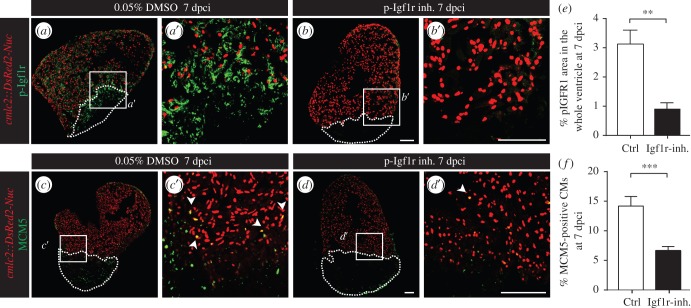
Inhibition of IGF signalling impairs CM proliferation. (a–d) Sections of cmlc2::DsRed2-Nuc (red) hearts at 7 dpci reveal that the treatment with 5 µM NVP-ADW742 (inhibitor of Igf1r) significantly reduces p-Igf1r levels (a,b, green) and MCM5-positive CMs (c,d, green). (e–f) Quantification of p-Igf1r (e, N ≥ 4) and the number of proliferating CMs (f, N ≥ 10) in the whole ventricles at 7 dpci. **p < 0.01, ***p < 0.001. Dashed lines encircle the cryoinjured areas. Scale bars, 100 µm.